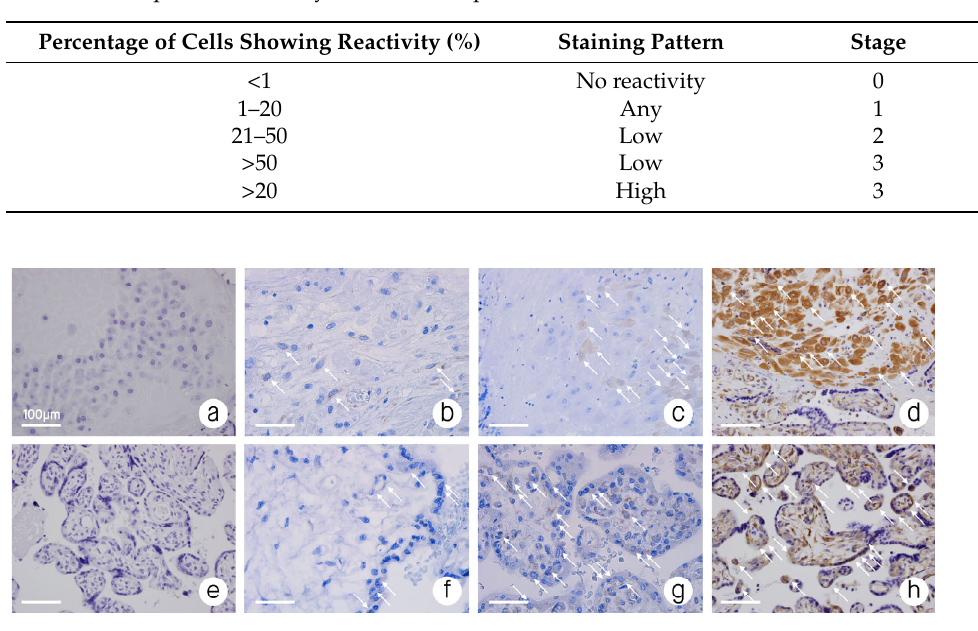
Table 2. Semi-quantitative analysis of B7-H4 expression in the examined tissues.